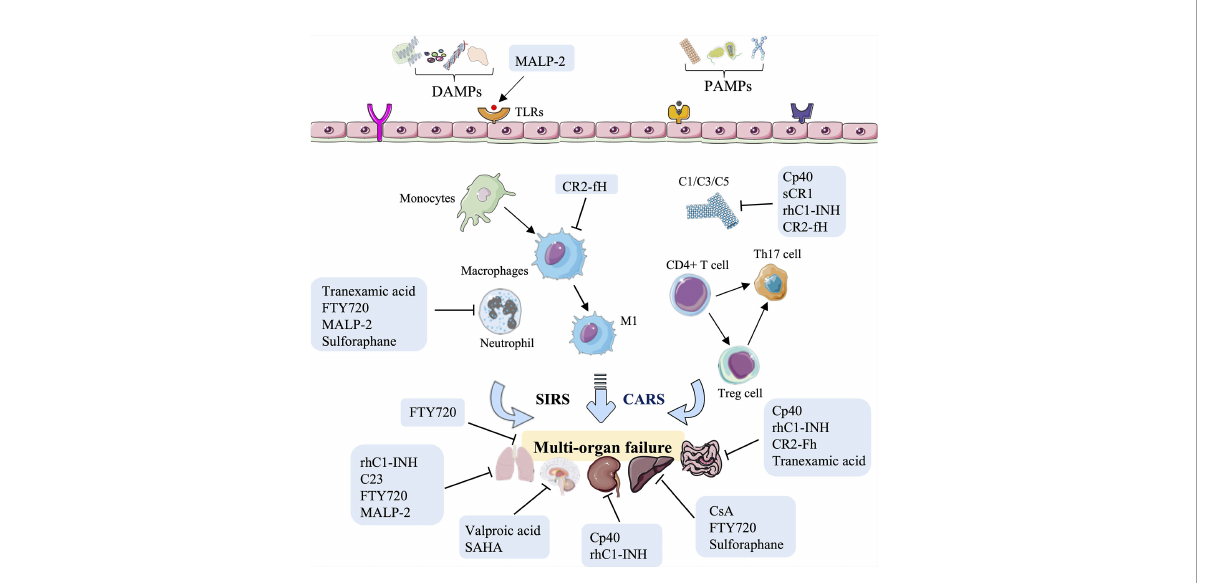
FIGURE 4 Overview of the immune therapeutic strategies of small molecule inhibitors or agonists in hemorrhagic shock. Small molecule inhibitors or agonists, especially complement-related target inhibitors, such as compstatin-40 (Cp40), soluble form of CR1 (sCR1), recombinant human C1- esterase inhibitor (rhC1-INH), complement receptor 2-targeted factor H (CR2-fH), tranexamic acid, CIRP-derived oligopeptide-23 (C23), FTY720, macrophage-activating lipopeptide-2 (MALP-2), cyclosporine A (CsA), and sulforaphane can reduce HS-induced liver, kidney, intestinal, lung, and multi-organ failure injury by reducing complement activation, macrophage in fi ltration, neutrophil priming, and systemic in fl